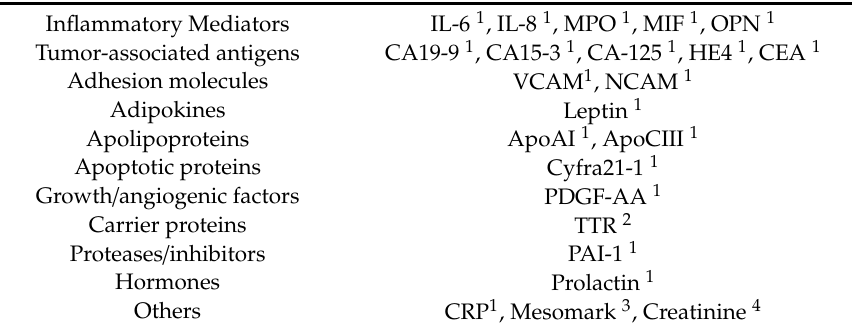
Table 5. Complete list of multiplexed